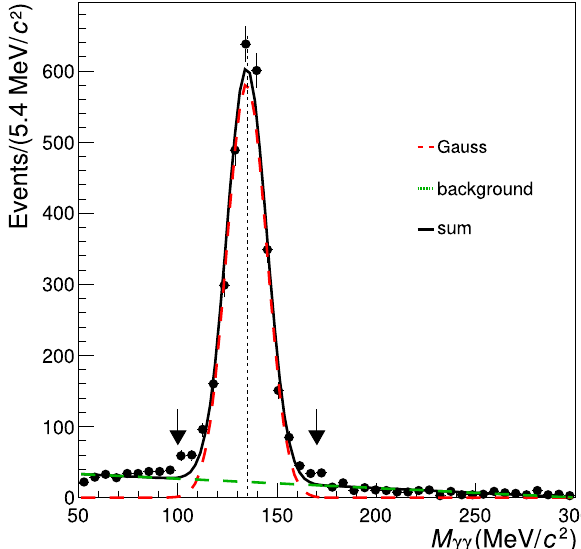
Fig. 2 Distribution of the two-photon invariant mass fitted by a Gaus- sian function and a linear background. The dashed vertical line denotes the PDG value of the π 0 mass. The black arrows indicate the selection